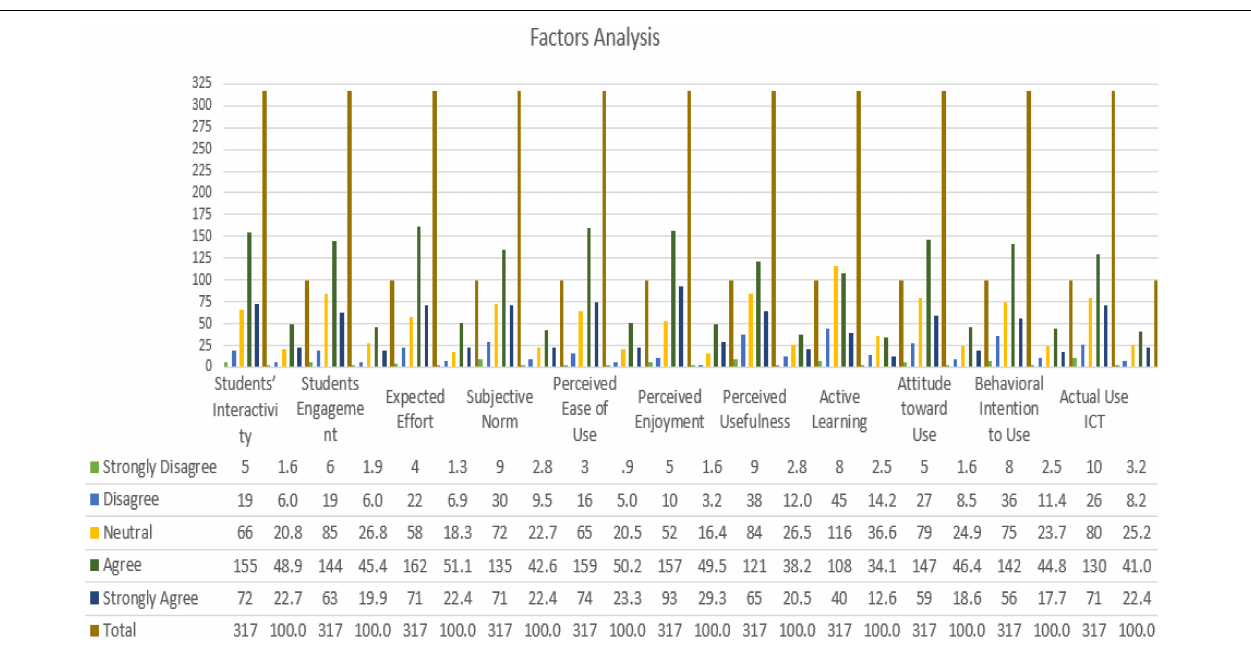
FIGURE 5 | Factors described and